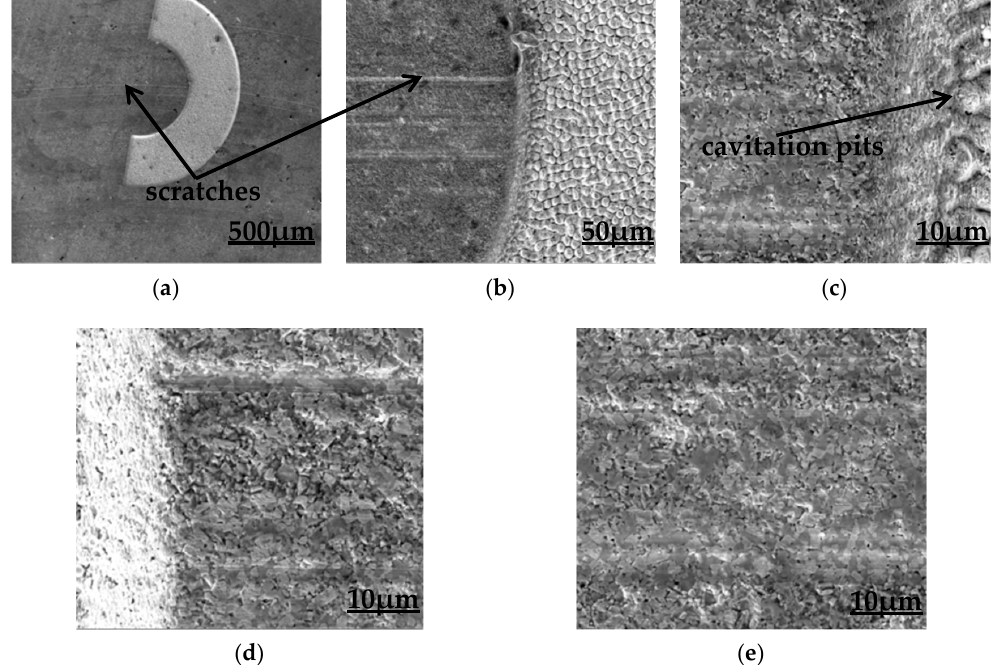
Figure 17. Surface wear morphology of semicircular ring textured specimens. ( a ) Semicircular ring textured surface wear morphology with a scale of 500 µ m; ( b ) Semicircular ring textured surface wear morphology with a scale of 50 µ m; ( c ) Semicircular ring textured surface wear morphology with a scale of 10 µ m; ( d ) Semicircular ring textured surface wear morphology with a scale of 10 µ m; ( e ) Semicircular ring textured surface wear morphology with a scale of 10 μ m.